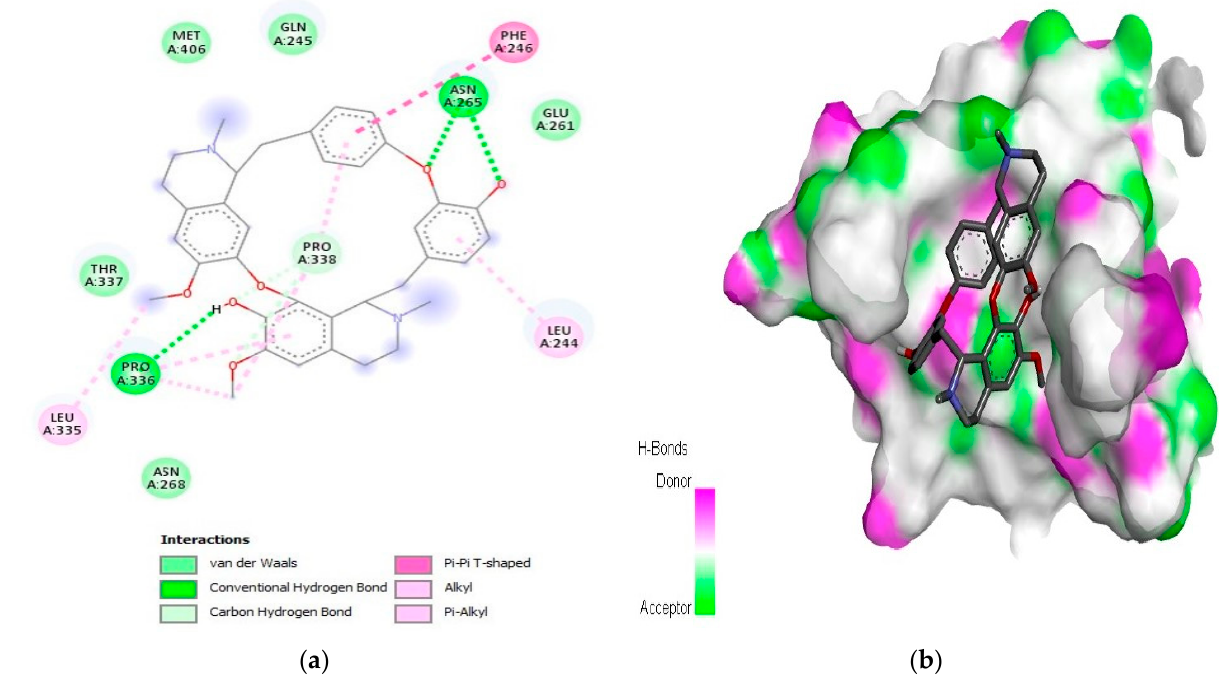
Figure 4. Interaction ( a ) and pattern of binding ( b ) of obamegine with caspase-9 as a receptor. Table 2. Drug-like properties of the best-selected